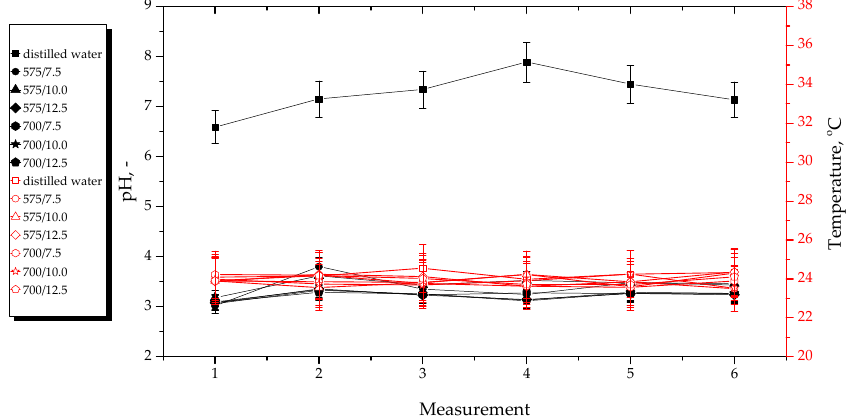
Figure 11. pH and temperature measurements during incubation of hydrogels in distilled water.